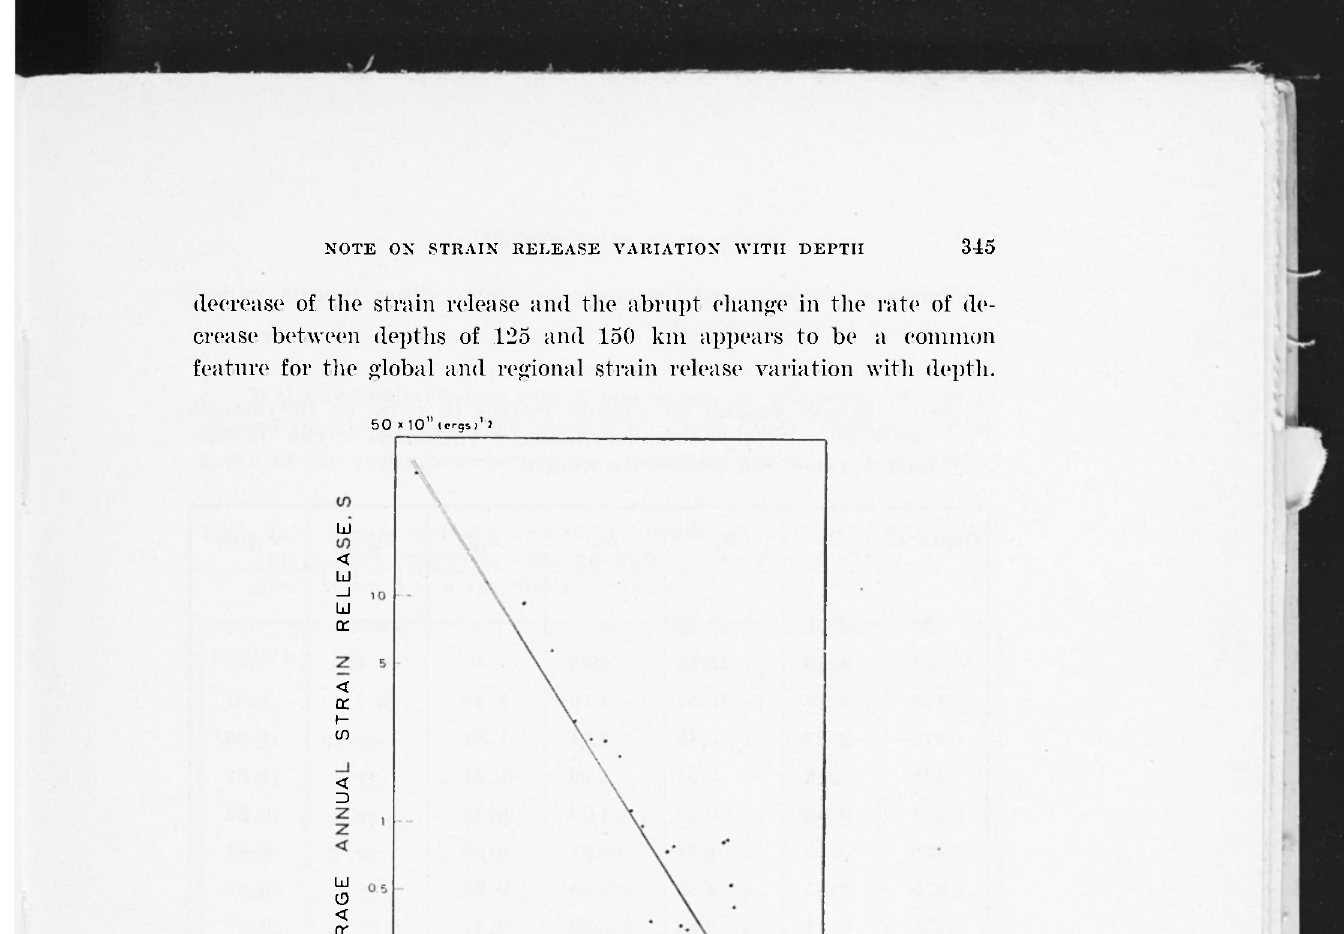
Fig. 7 - Strain release versus (leptli in double log-coordinate